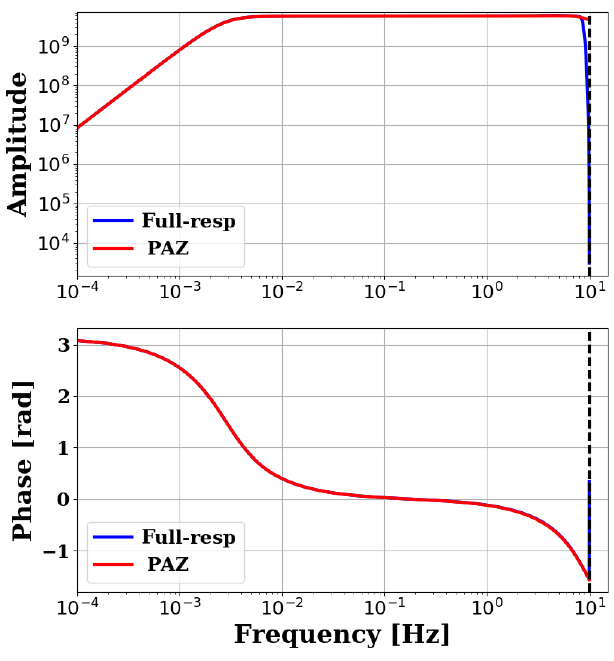
Figure 6. obspyDMT --plot_stationxml --plotxml_paz --plotxml_min_freq 0.0001 --datapath /path/to/STXML.IC.XAN.00.BHZ Transfer function spectra (amplitude and phase) of a Streck- eisen STS-1VBB w/E300 station (IC.XAN) in China. Blue lines show the transfer function components computed for all filter stages in a StationXML file; red lines are for the analog part. The two functions match very well in all frequencies except for the amplitude spectra close to the Nyquist frequency (dashed